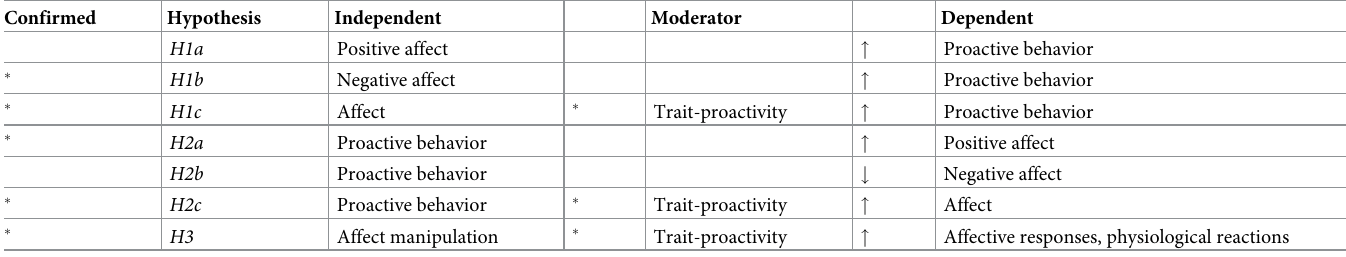
Table 5. Overview of hypotheses and their